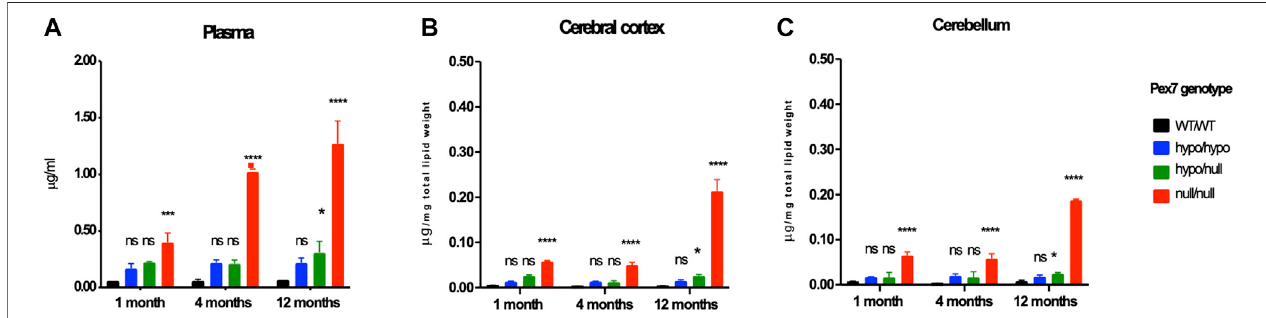
FIGURE 6 | Pex7 genotype correlates with PA levels. Graded accumulation of PA levels is detected in the plasma (A) , cerebral cortex (B) and cerebellum (C) of Pex7 de fi cient mouse models compared to WT controls. ( n = 2 – 4 per genotype). ns: nonsigni fi cant, * p < 0.05, ** p < 0.01, *** p < 0.001, **** p < 0.0001.